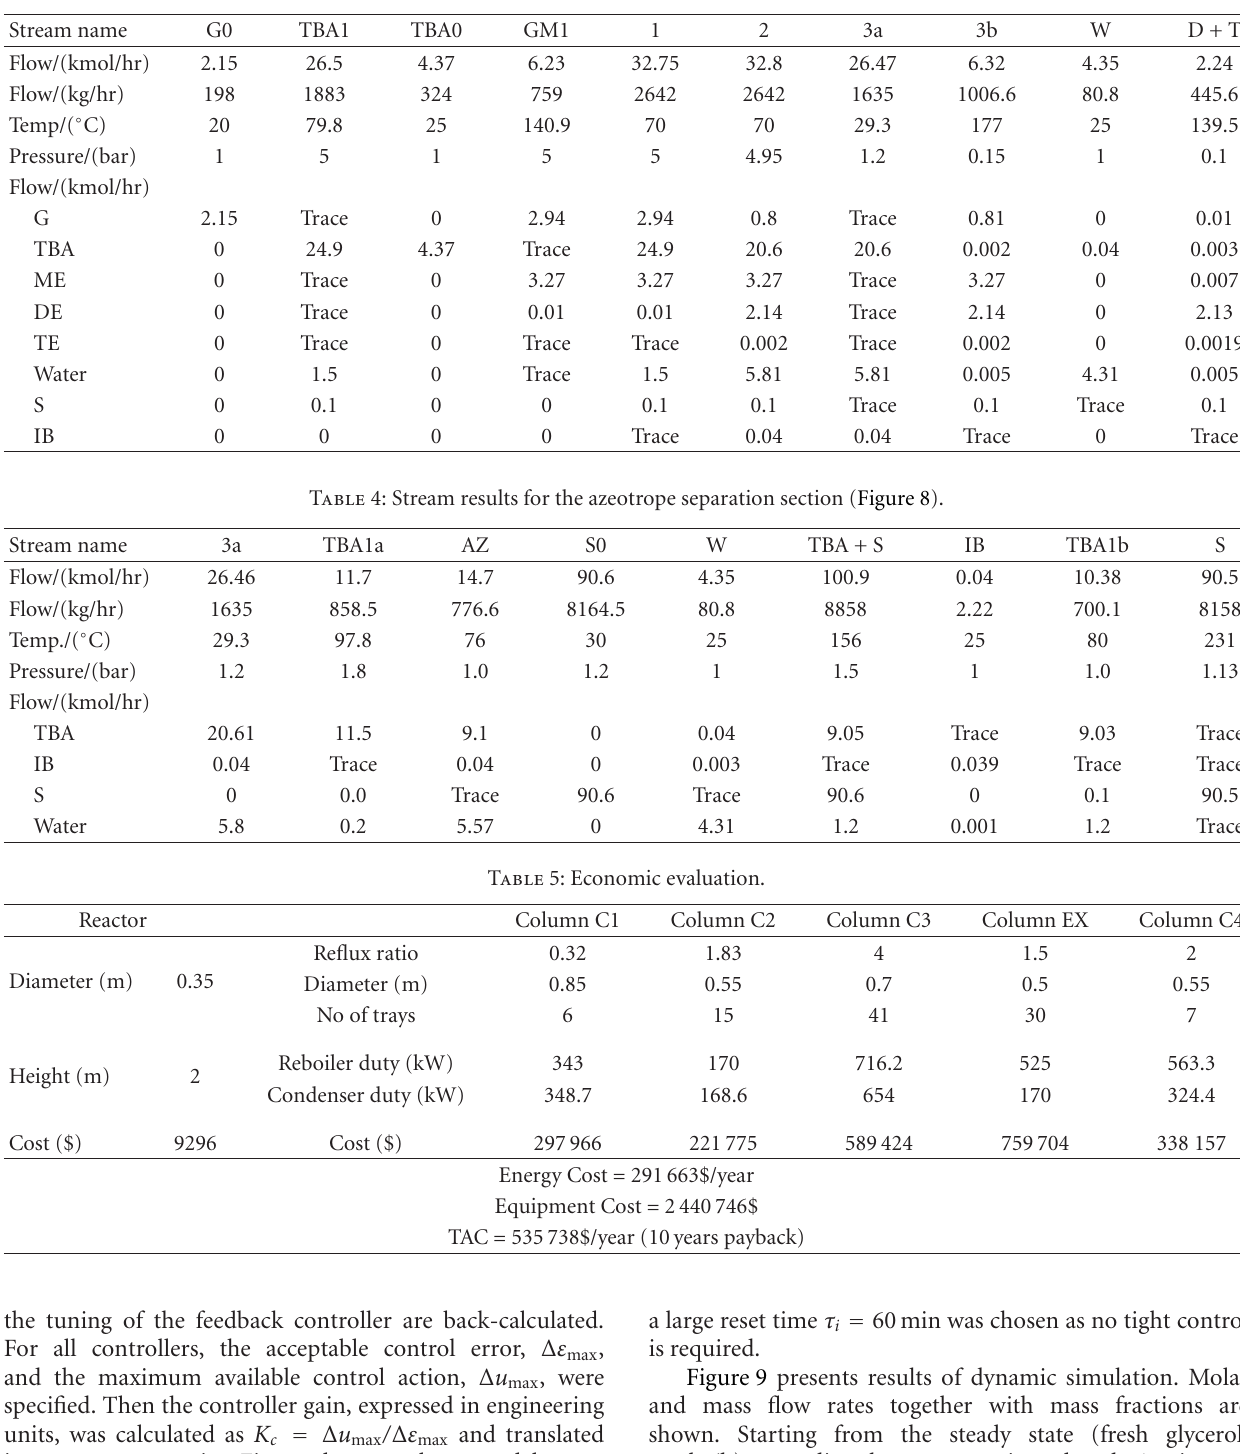
Table 3: Stream results for the reaction section (Figure 7).